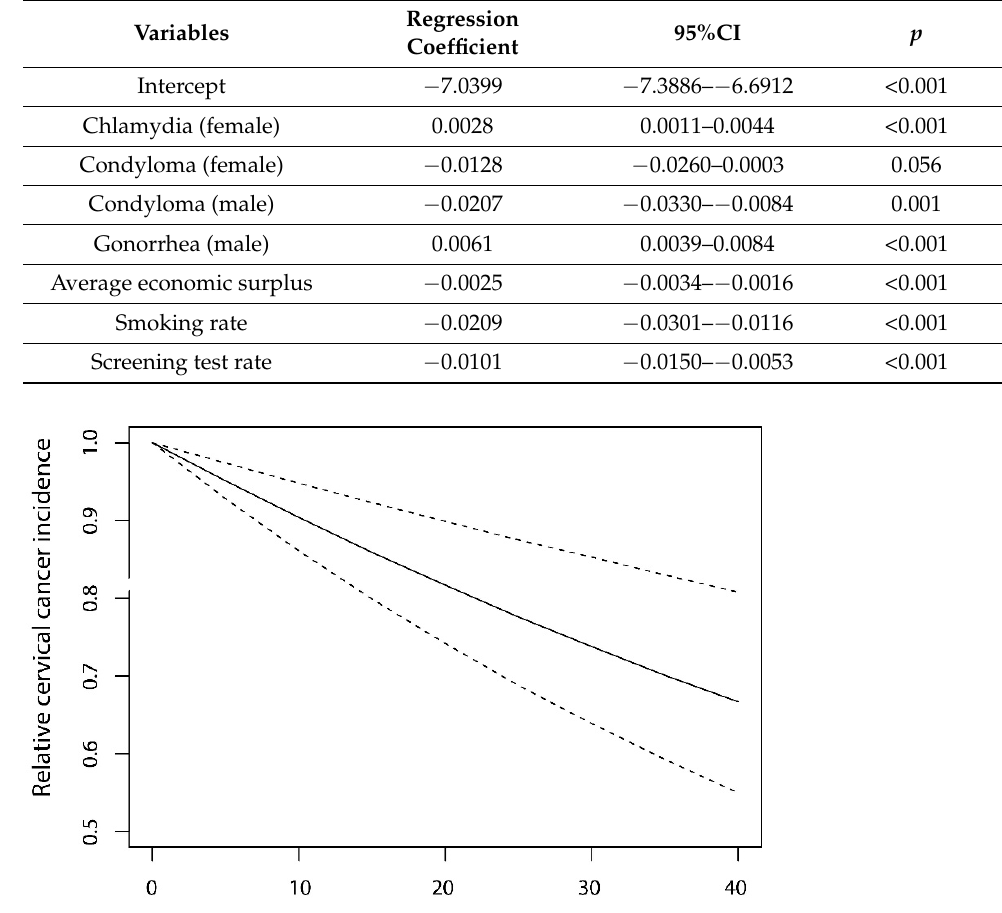
Table 3. The explanatory variables and the estimates of regression coefficients in the model with the lowest AIC among the 1088 negative binomial regression models for cervical cancer incidence.